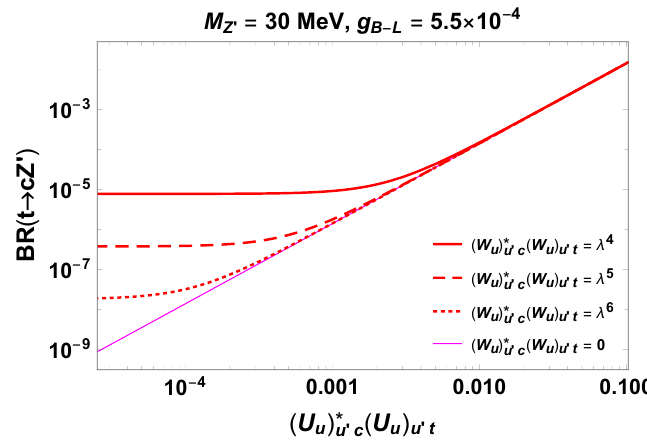
Figure 2 . Our predictions of BR( t ! cZ 0 ) as a function of ( U u ) (cid:3) and dotted lines show the case of ( W u ) (cid:3) magenta line shows the ( W u ) (cid:3)